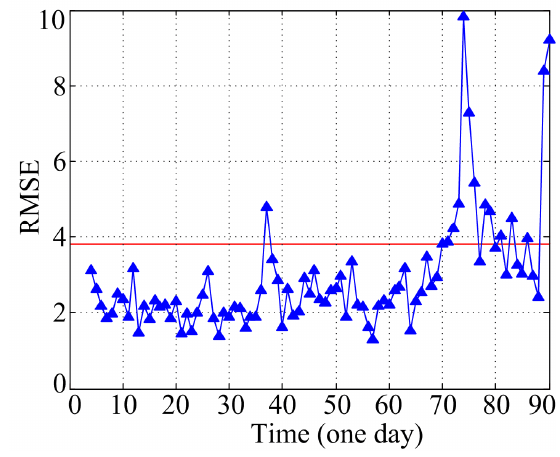
Figure 12. RMSE over one day of